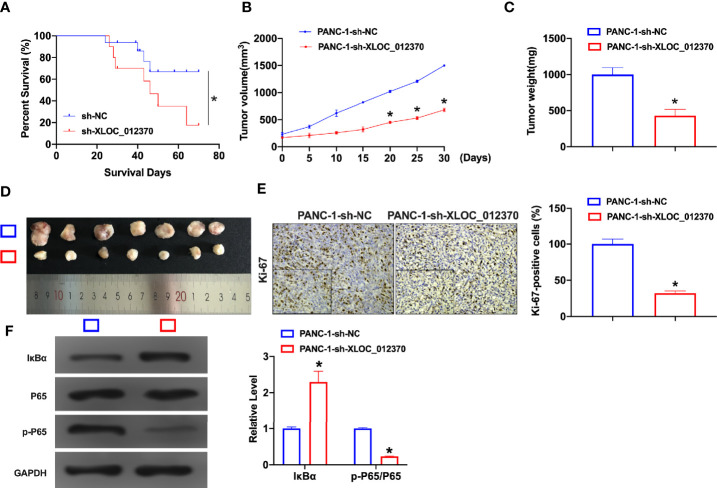
Sh-XLOC_012370 prevents tumor growth in vivo. (A) Kaplan–Meimer survival curve of tumor-bearing nude mice. *P < 0.05. (B, C) Tumor volume and tumor weight were analyzed. n=7, *P < 0.05. (D) Tumors removed from the mice 30 days, respectively n=7. (E) Representative image of ki-67 staining. (F) The protein level of IκBα, P65, and p-P65 were detected in the tumor. n=6, *P < 0.05.